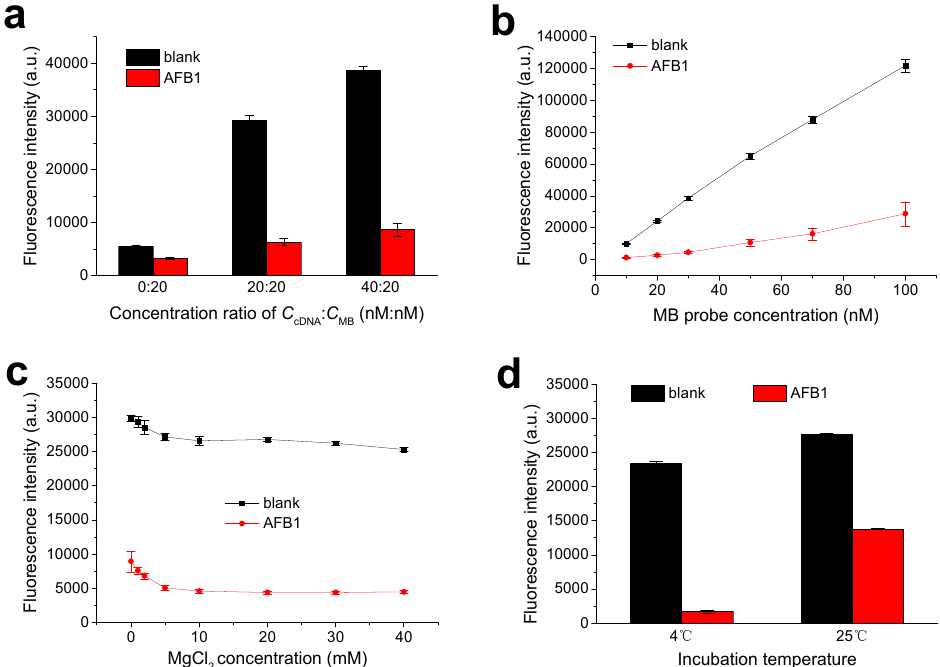
Figure 2. Optimizations of experimental conditions. ( a ) Fluorescence intensity of samples with or without AFB1 obtained with different concentration ratios between cDNA and MB; ( b ) fluorescence intensity of samples with or without AFB1 obtained with different concentrations of MB, when ratio value of C cDNA : C MB was fixed at 1:1; ( c ) fluorescence intensity of samples with or without AFB1 using assay buffer containing different concentrations of MgCl 2 and ( d ) fluorescence intensity of samples with or without AFB1 under different incubation temperatures.